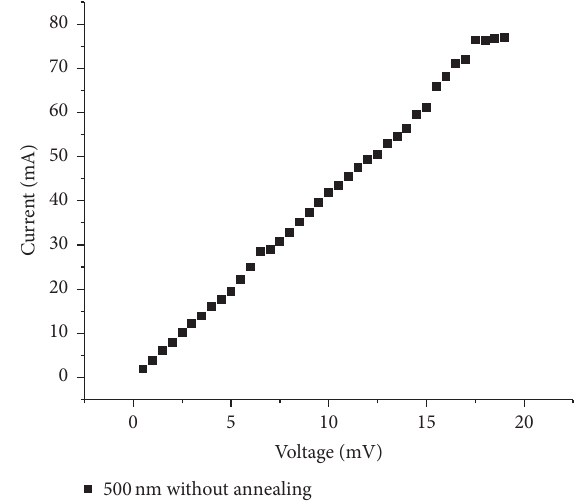
Figure 1: Dependence of voltage on current for a sample not subjected to annealing.